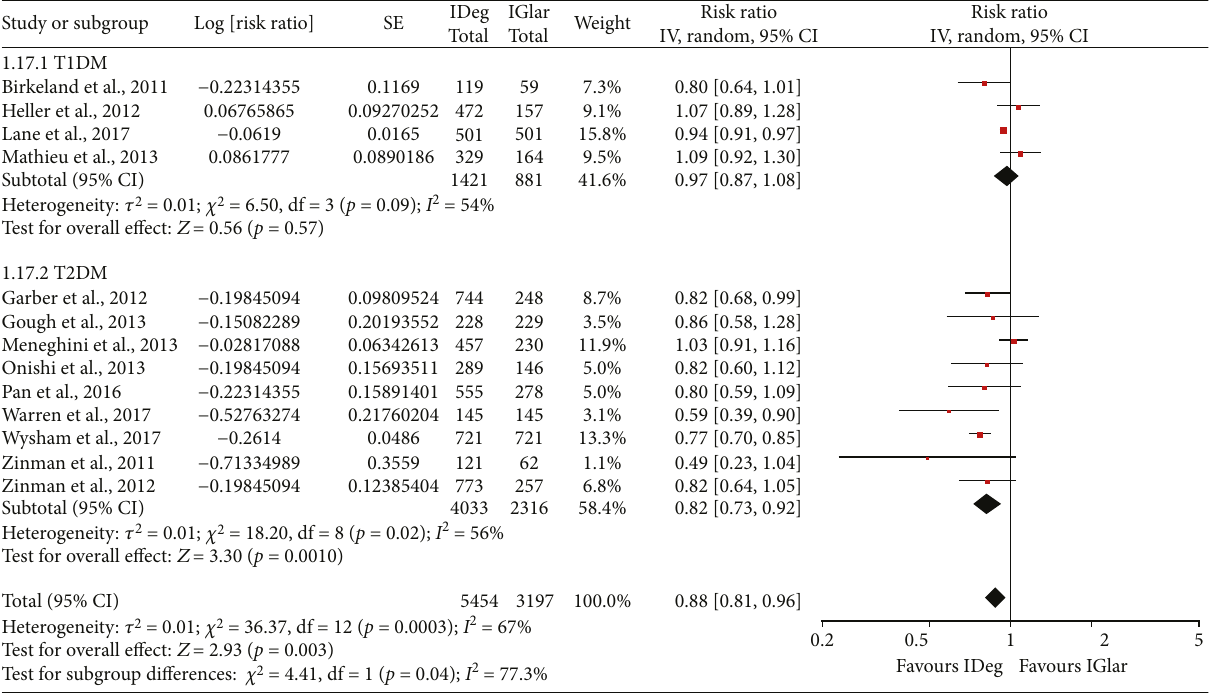
Figure 3: Comparison of the risk of overall hypoglycemia (events per patient-year of episode) between IDeg and IGlar across subgroups: the abbreviations are the same as Figure 1.